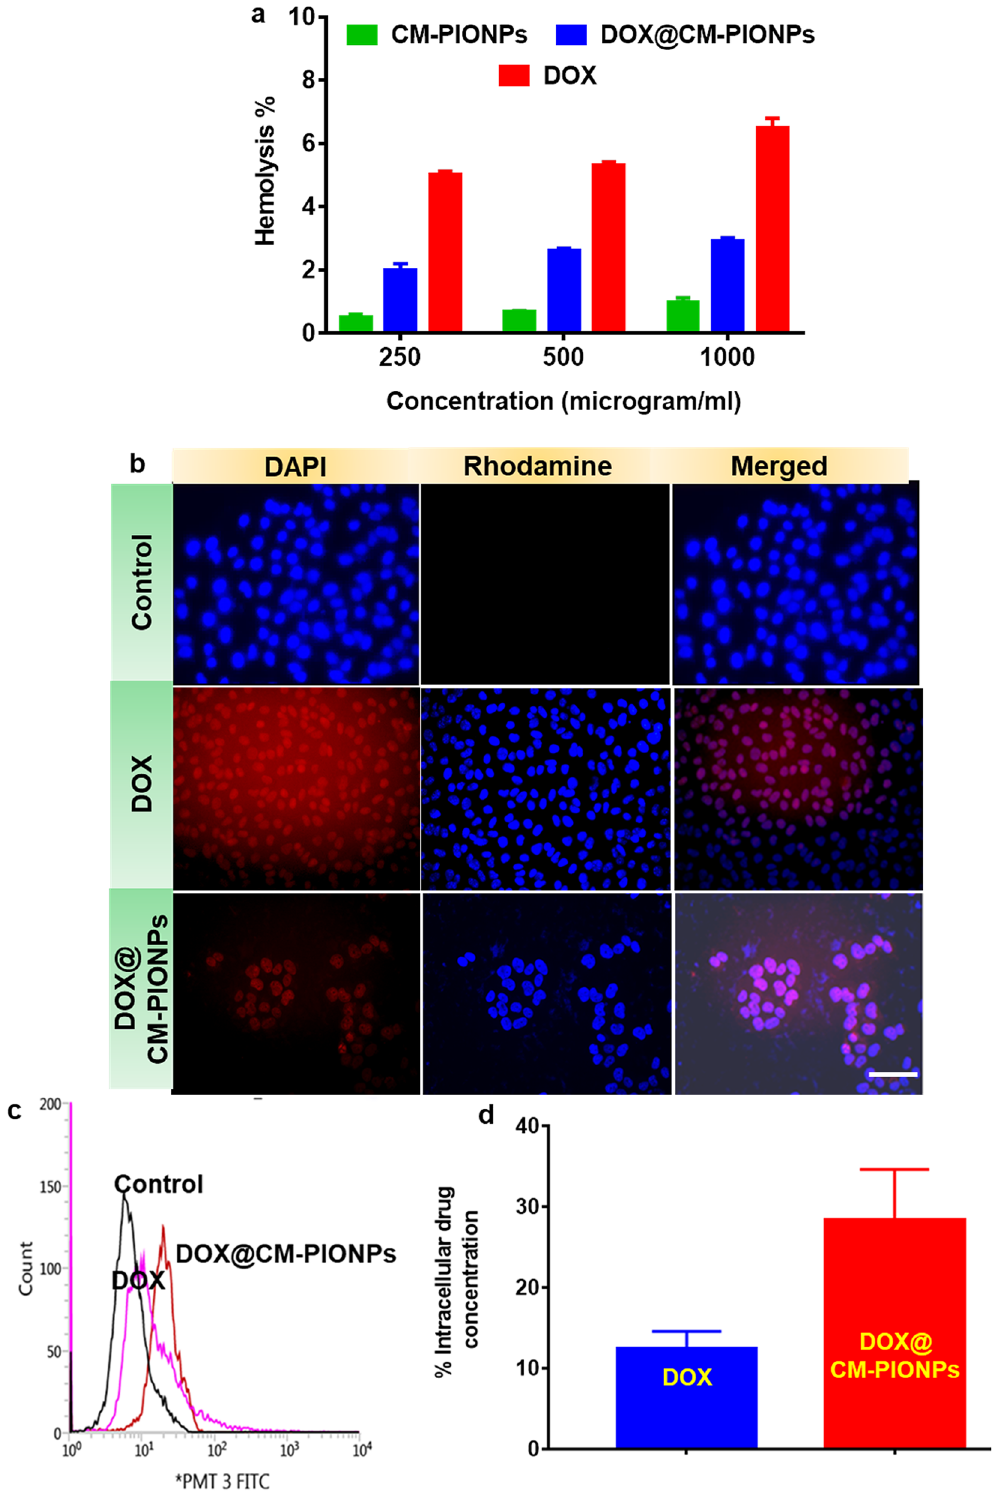
Figure 2. ( a ) Hemocompatibility assay. The result clearly shows that both CM-PIONPs and DOX@ CM-PIONPs exhibited less than 3% hemolysis compared to DOX. ( b ) Cellular uptake of DOX and DOX@ CM-PIONPs in A549 cells. DOX@CM-PIONPs was internalized within the cytosol of the cells after 3 h of incubation which proposes it’s as a drug delivery system. ( c ) Flow cytometric cellular uptake analysis. The cells treated with DOX@CM-PIONPs exhibited more fluorescence intensity (> 10 1 ) compared to cells treated with DOX ( d ) Quantitative cellular uptake in A549 cells using HPLC. The uptake efficiency of nanoparticles in A549 was found to two-time more than the free drug. Scale bar corresponds to 50 µm. The experiments were carried out in triplicates and error bars denote standard